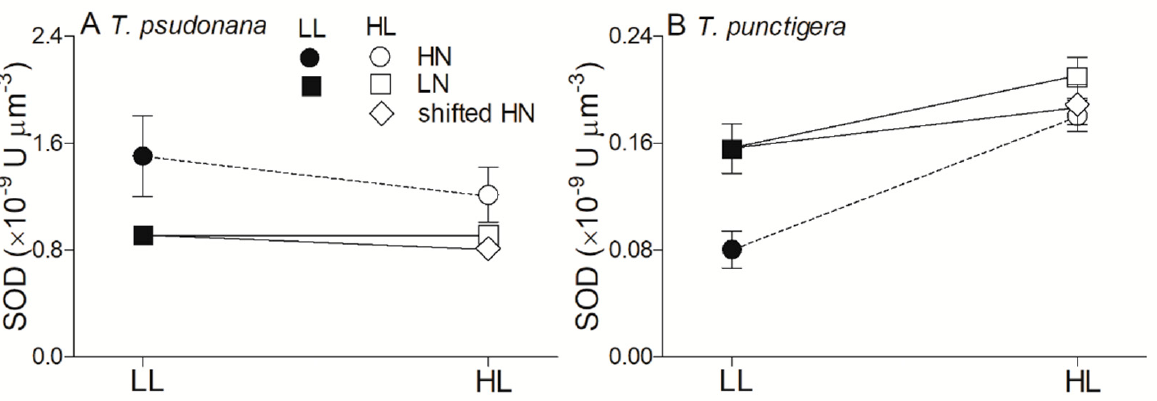
Figure 6. Cell biovolume-based superoxide dismutase (SOD) activity ( × 10 − 9 U µ m − 3 ) of small T. pseudonana ( A ) and large T. punctigera ( B ) grown under low and shifted-high lights, and under low and high/shifted-high nitrogen conditions. Points show averages of measurements on three independently grown cultures, and error bars show the standard deviations ( n = 3), often within sym- bols.